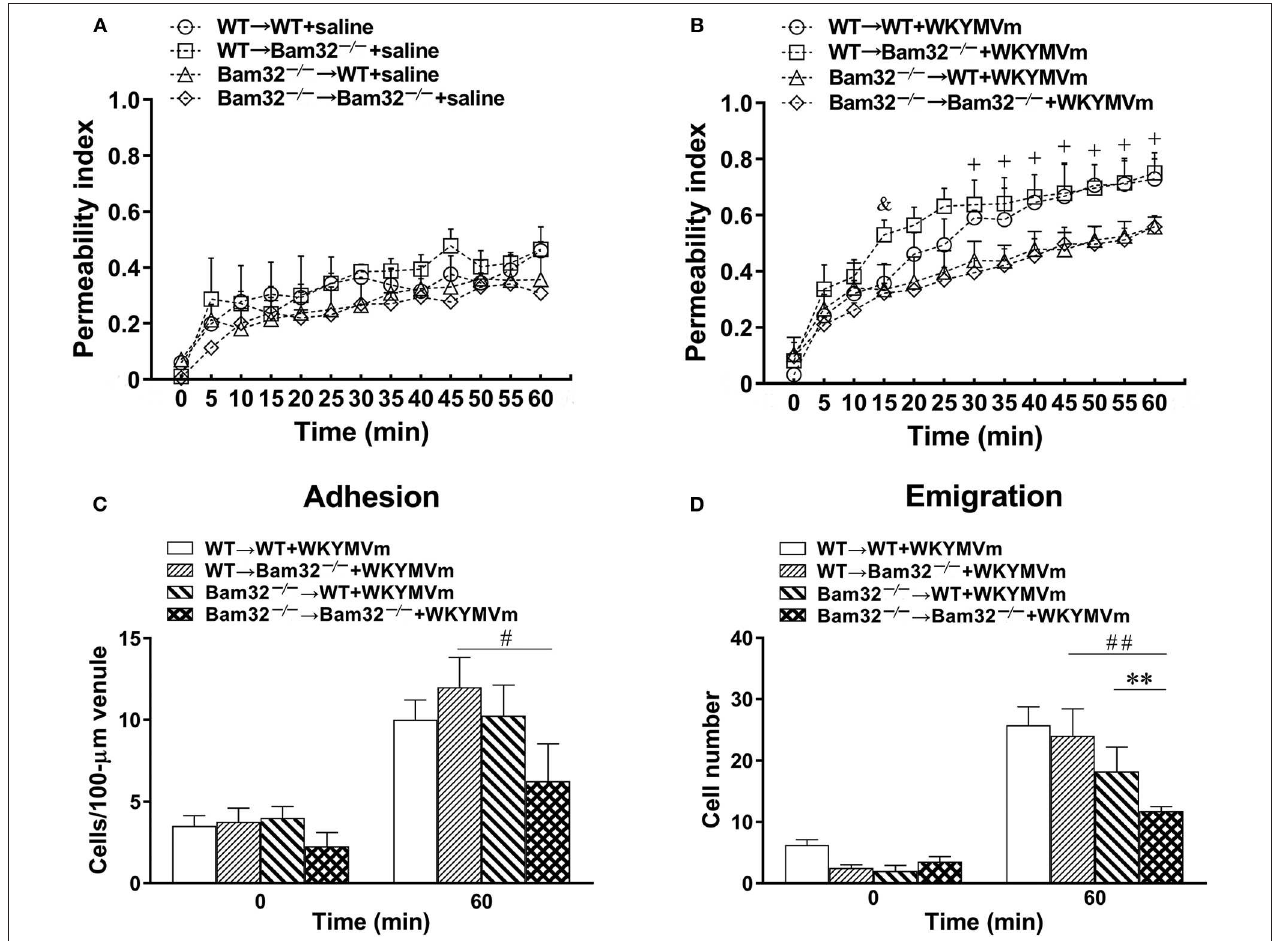
FIGURE 2 | WKYMVm-induced microvascular hyperpermeability in bone marrow chimeric mice. Bone marrow chimeric mice were generated as described in Material and Methods for determination of the impact of Bam32 deficiency within hematopoietic (bone marrow derived) vs. radiation-resistant non-hematopoietic